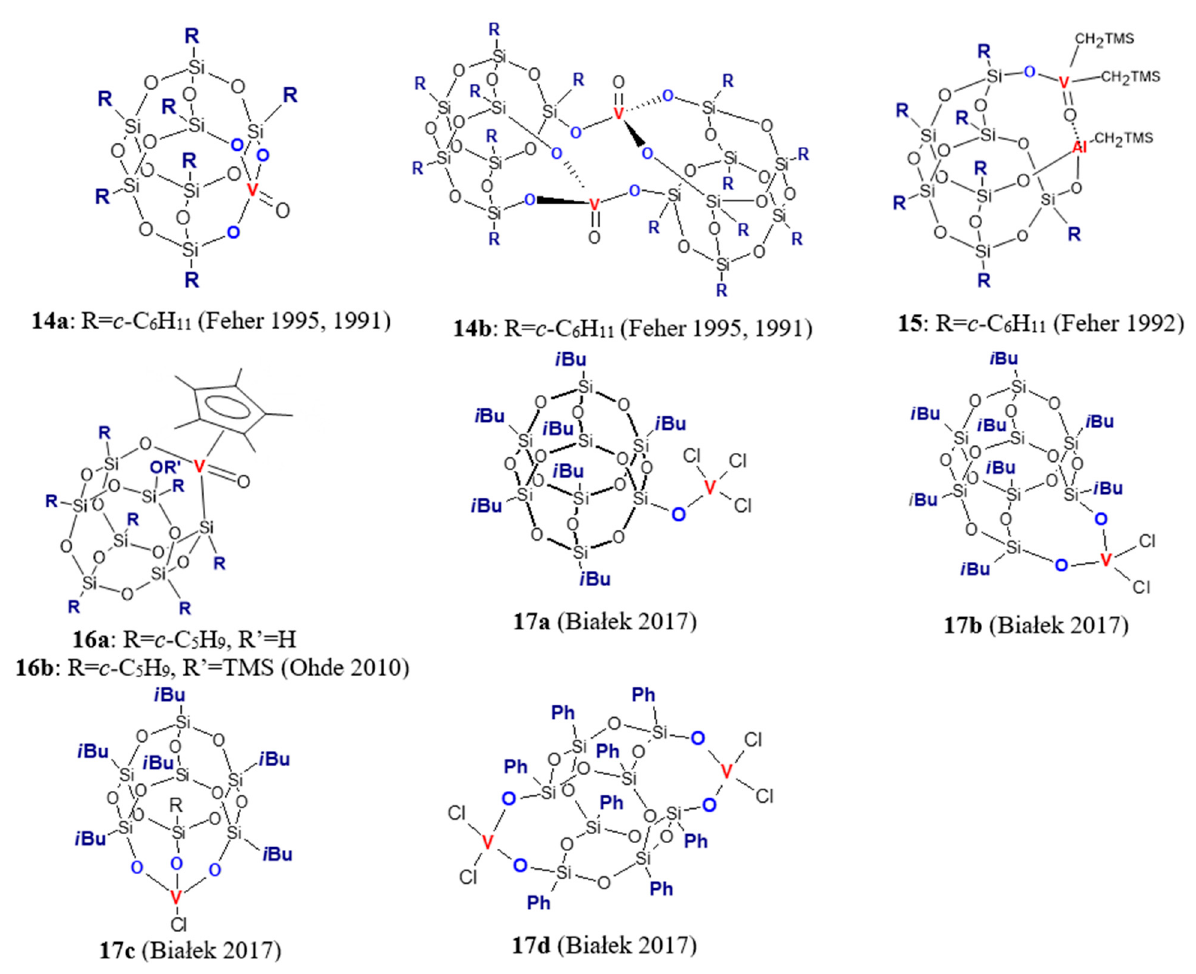
Figure 3. Silsesquioxane complexes of vanadium used in olefin polymerization